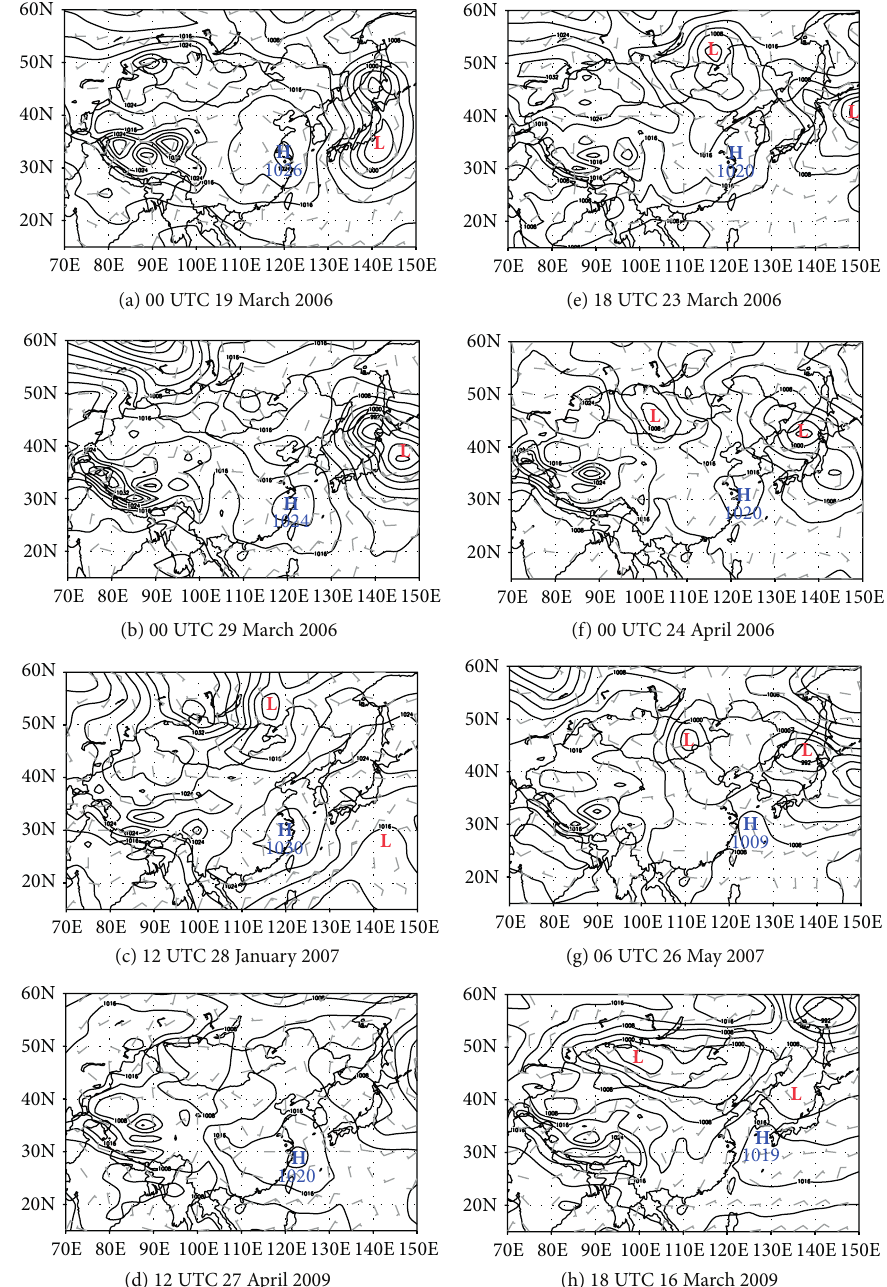
Figure 3: Surface weather maps for the (a)–(d) southeastward and (e)–(h) eastward dust events. The full barb and half barb represent 10 and 5ms −1 , respectively. Sea-level pressure is analyzed at 4hPa